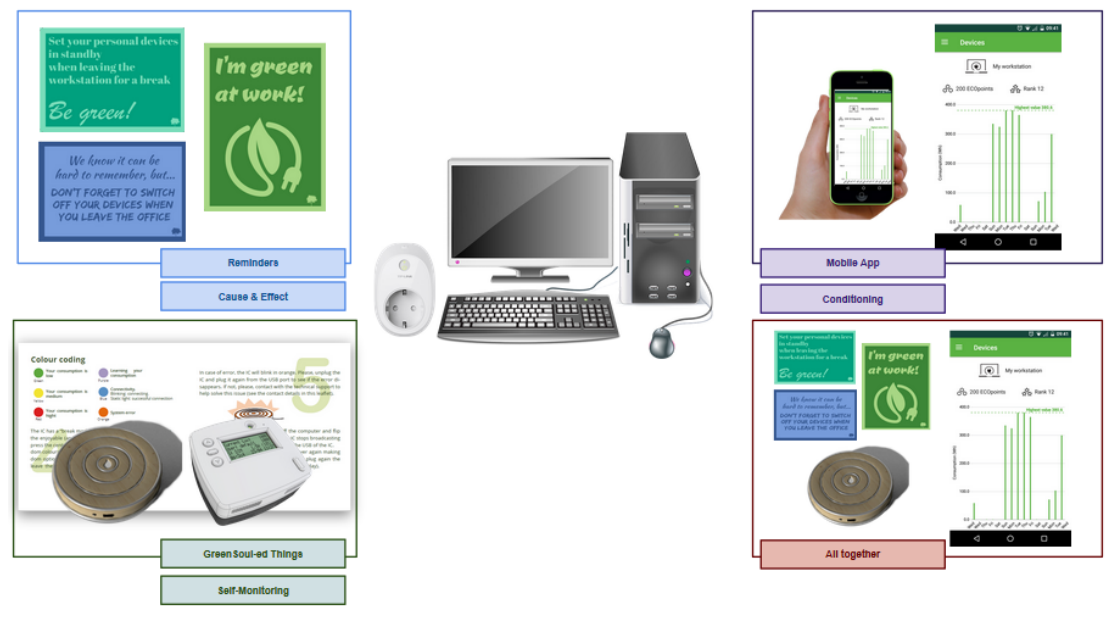
Figure 1. The GreenSoul persuasion